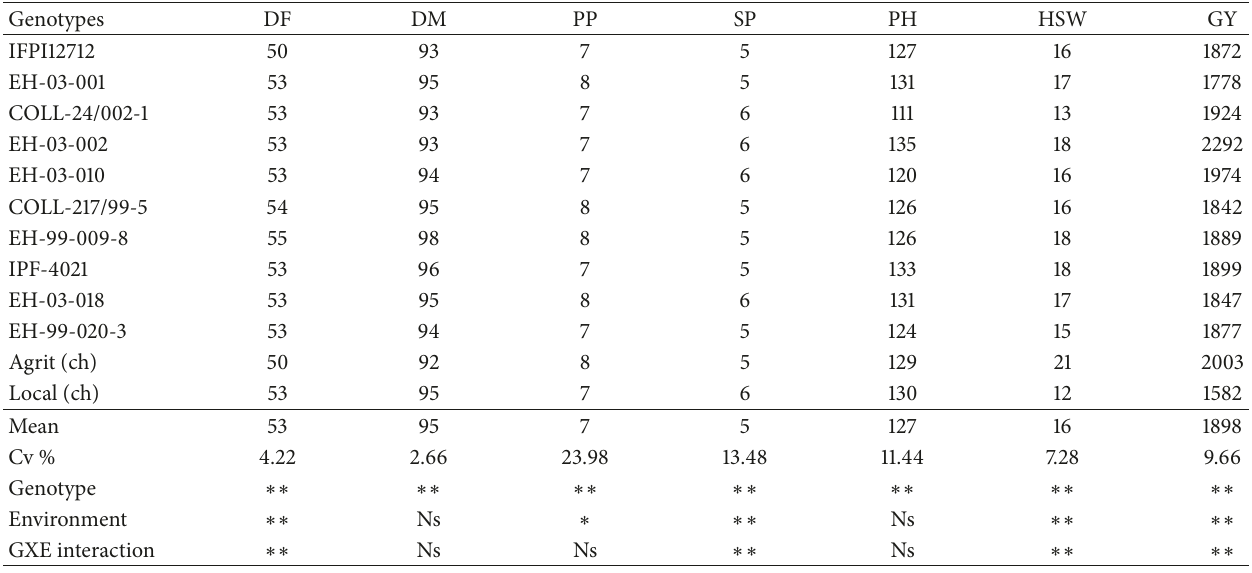
Table 3: Combined means of grain yield and yield-related traits of 12 field pea genotypes grown at seven environments.